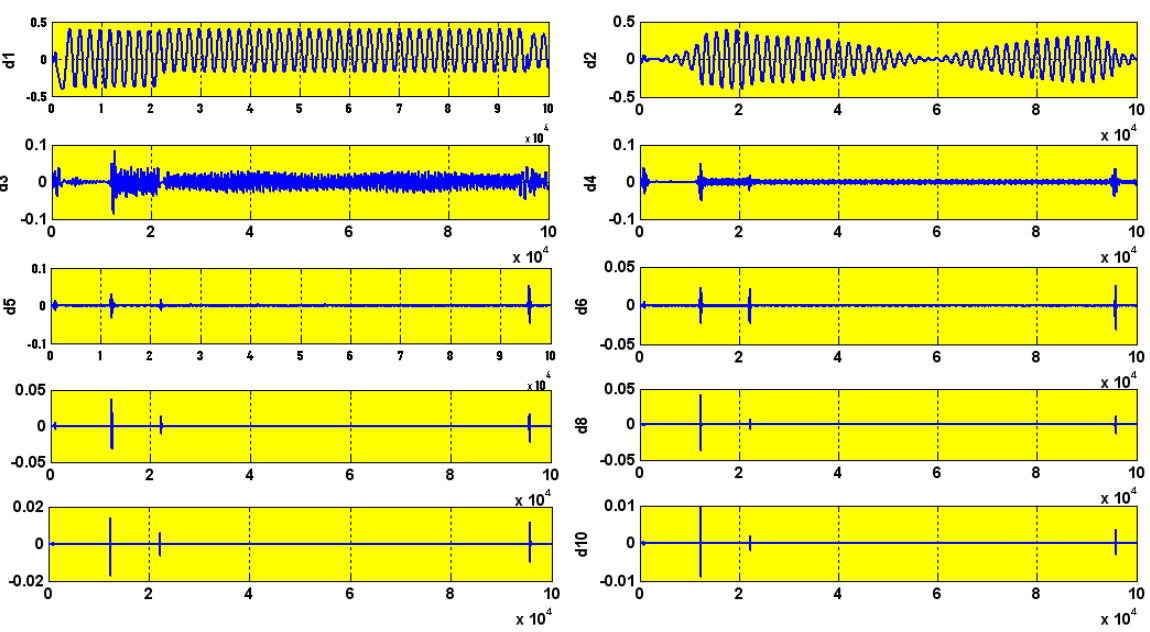
Figure 19. Wavelet decomposition Rs = 200 Ω .